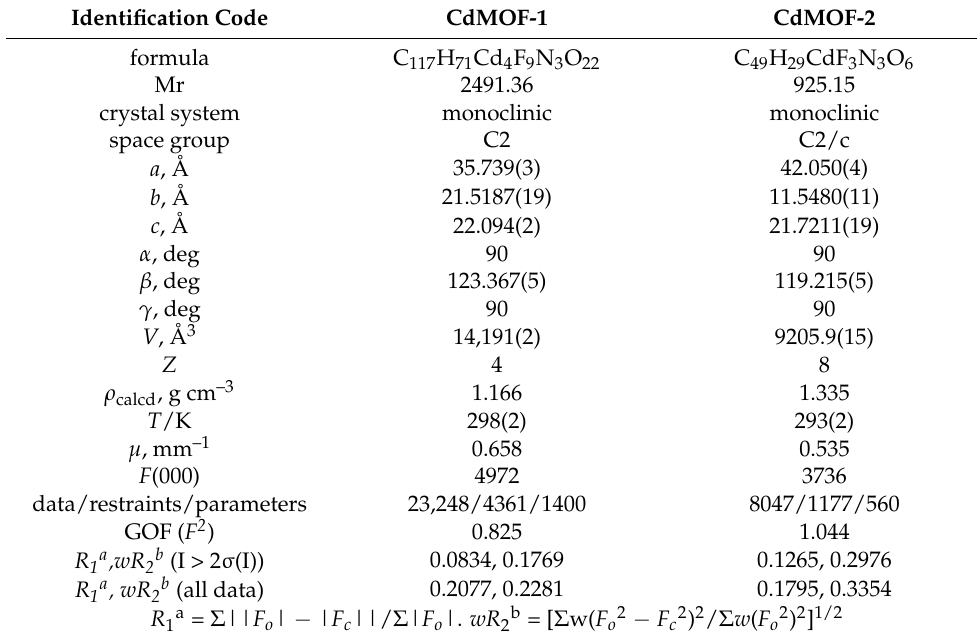
Table 1. Summary of crystallographic data for CdMOF-1-2